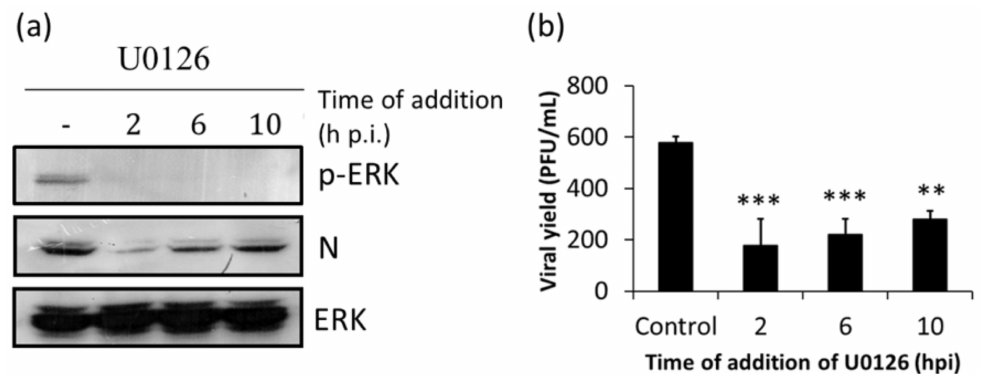
Figure 2. U0126 inhibits N protein expression and viral production. Vero cells were infected with JUNV (m.o.i. = 1) and at different time points U0126 (15 µ M) was added. At 14 h p.i. cells were lysed and the levels of expression of N and p-ERK were analyzed by Western blot using ERK as loading control ( a ), and virus production was determined by plaque assay ( b ). Data are mean values ± SD. ANOVA (Dunnett post-hoc test): ** p < 0.01, *** p <